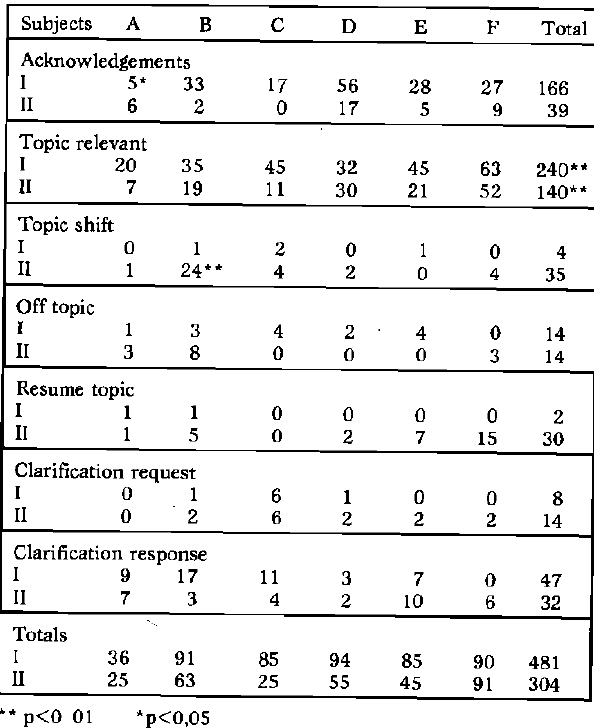
Table 7: Variation within Topic Extension for all subjects in Interactions I and Π.